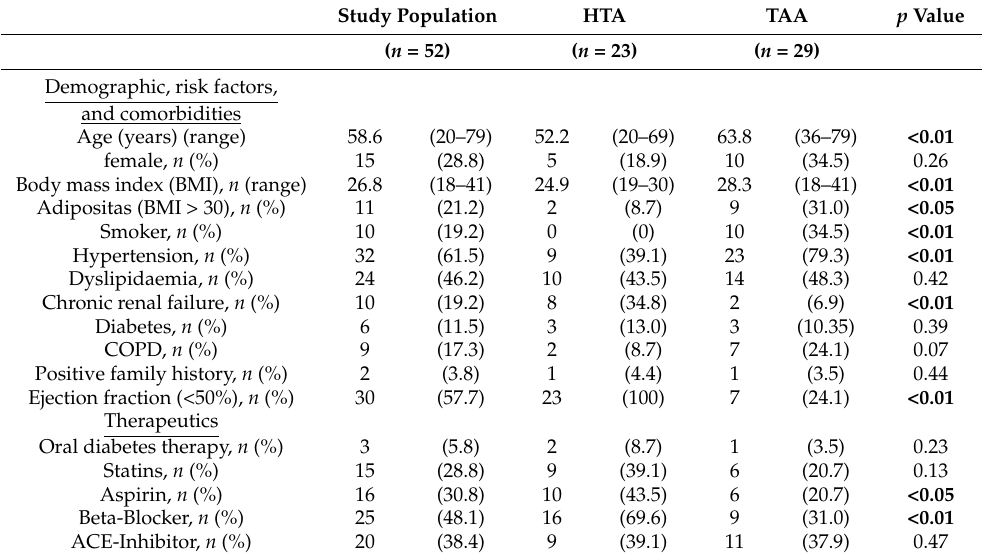
Table 1. Characteristics of the study population.